Question: Provide a one-line summary of what is displayed.
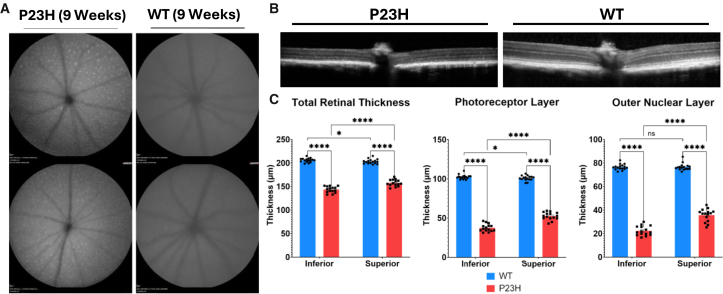
Answer: Rapid outer retinal degeneration in Rho(P23H) mice (A) SLO comparison of 9-week-old Rho(P23H) mice versus age-matched wild-type (C57BL6/J) controls. Hyperreflective spots are visible on Rho(P23H) SLO. (B) OCT comparison of Rho(P23H) versus age-matched controls. (C) Quantification of retinal thickness at 9 weeks of age in Rho(P23H) ( n = 8) versus control ( n = 8) mice. ∗∗∗∗ p < 0.0001 two-way ANOVA.